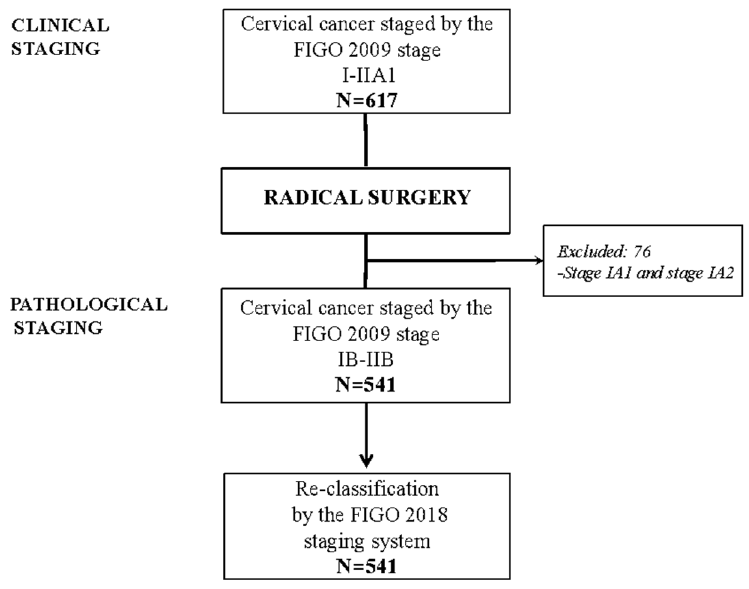
Figure 1. Flow chart of patients in the series. FIGO: International Federation of Gynecology and Obstetrics.